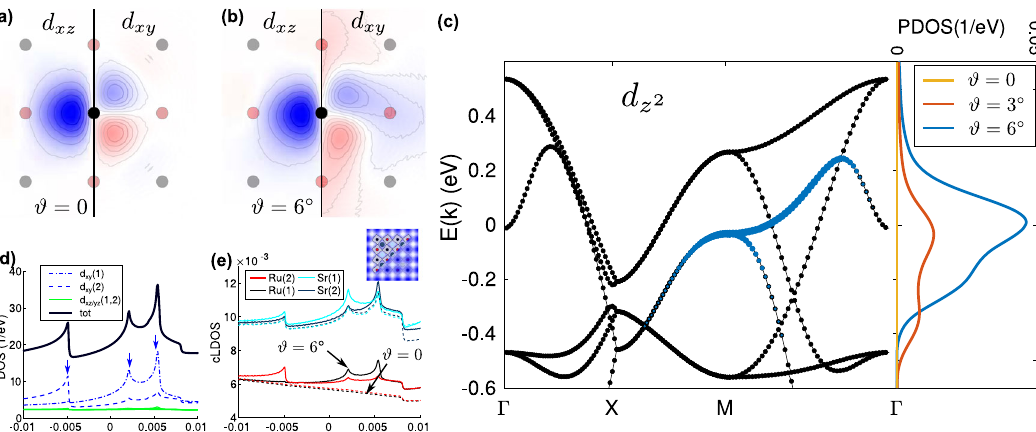
Fig. 2 Tunneling probabilities and the surface reconstruction. a Calculated cross-sections in the xy plane 5 Å above the unreconstructed Sr 2 RuO 4 surface of d xz and d xy Wannier functions. b Same, but for the reconstructed surface in the presence of ϑ = 6 ∘ O-octahedron rotation. Black dot represents the position of the Ru(1) atom, gray dots the neighboring Ru(1) atoms, and light red dots the Ru(2) atoms. c DFT band structure for the reconstructed surface with ϑ = 6 ∘ employed in this work, with d z 2 orbital weight highlighted in blue. The right panel shows the projected d z 2 density of states for ϑ = 6 ∘ as in the panel on the left, as well as for ϑ = 3 ∘ and 0 ∘ (red, yellow). d Lattice density of states from the model described in the text (black: total; blue: d xy on the Ru(1) and Ru(2) atoms exhibiting peaks at the positions marked with arrows, green: d xz / yz (approximately fourfold degenerate) with only tiny structure within the energy range shown). e Continuum density of states (cLDOS) evaluated 5 Å above the surface above the two inequivalent Ru atoms and above the two inequivalent Sr atoms, see inset. Solid lines show results using Wannier functions with octahedral rotation and exhibit features at the peaks of the d xy lattice DOS, whereas a calculation using Wannier functions without octahedral rotation yields a completely fl at cLDOS above the Ru positions within this energy